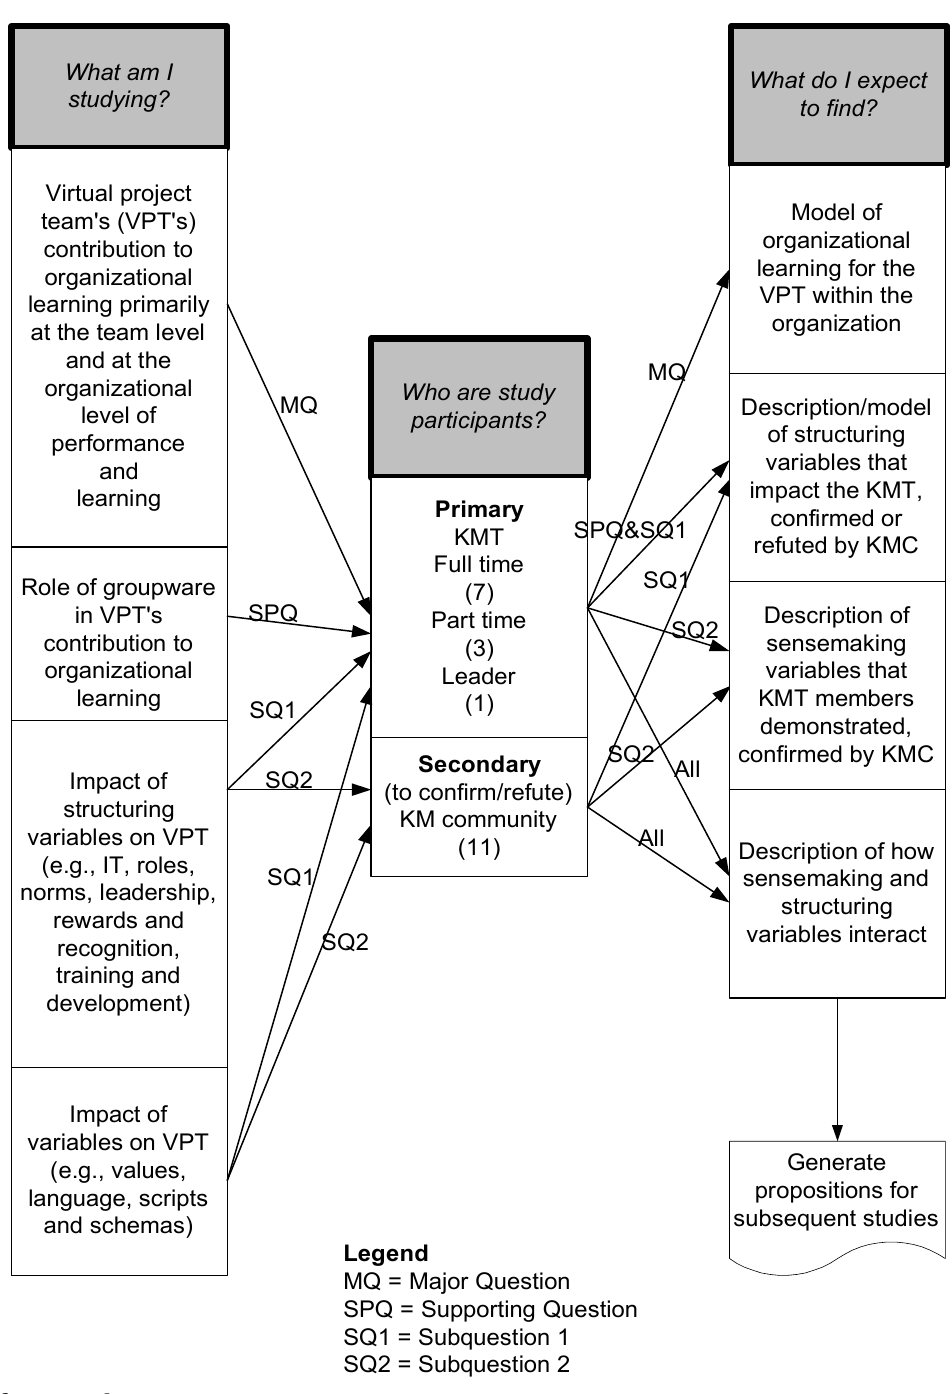
Figure 1: Study framework The 14-month research fieldwork was primarily based on semi-structured individual interviews. Initially, preliminary mapping was designed for background and context information, as well as to familiarize the data researcher (only Dr. Gorelick conducted data collection) with the structure, language, and history of both BP and the KMT (knowledge management team), and familiarize the team and KMC members (knowledge management community of practice) with the data